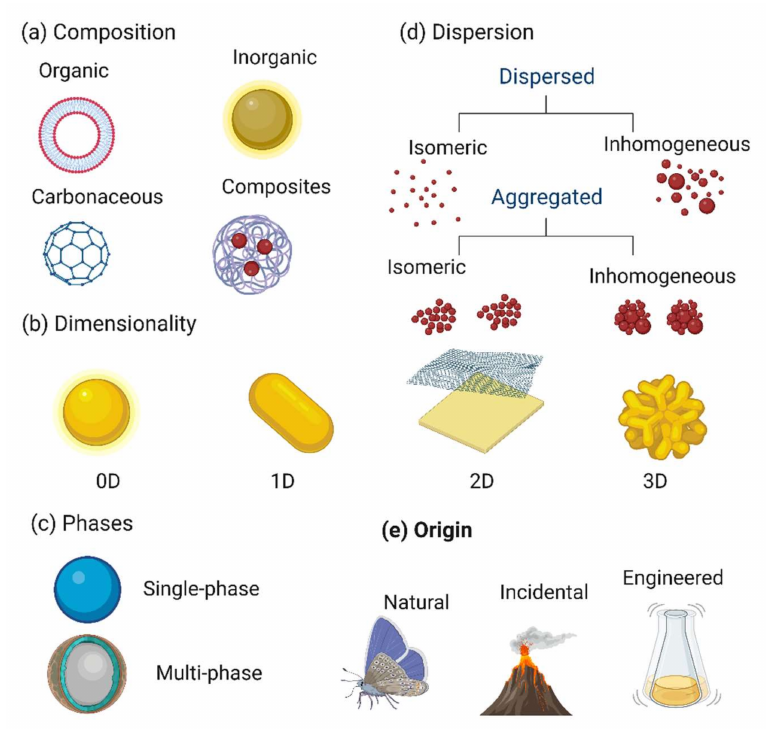
Figure 1. Illustration of how nanomaterials can be classified in function of their composition, dimen- sionality, phases, dispersion, and origin. Image created with